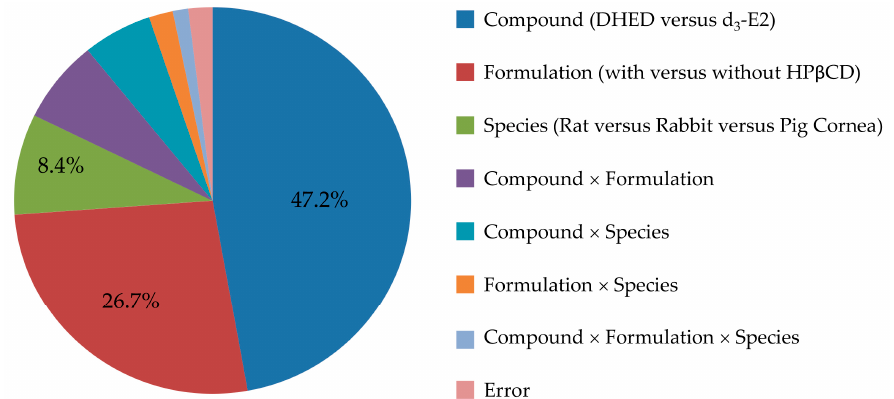
Figure 2. Relative effect sizes ( η 2 × 100) for compound, formulation, choice of animal species and their interactions calculated from the ANOVA of our 2 × 2 × 3 factorial experiment evaluating transcorneal permeabilities (Table 1 and Table S1).